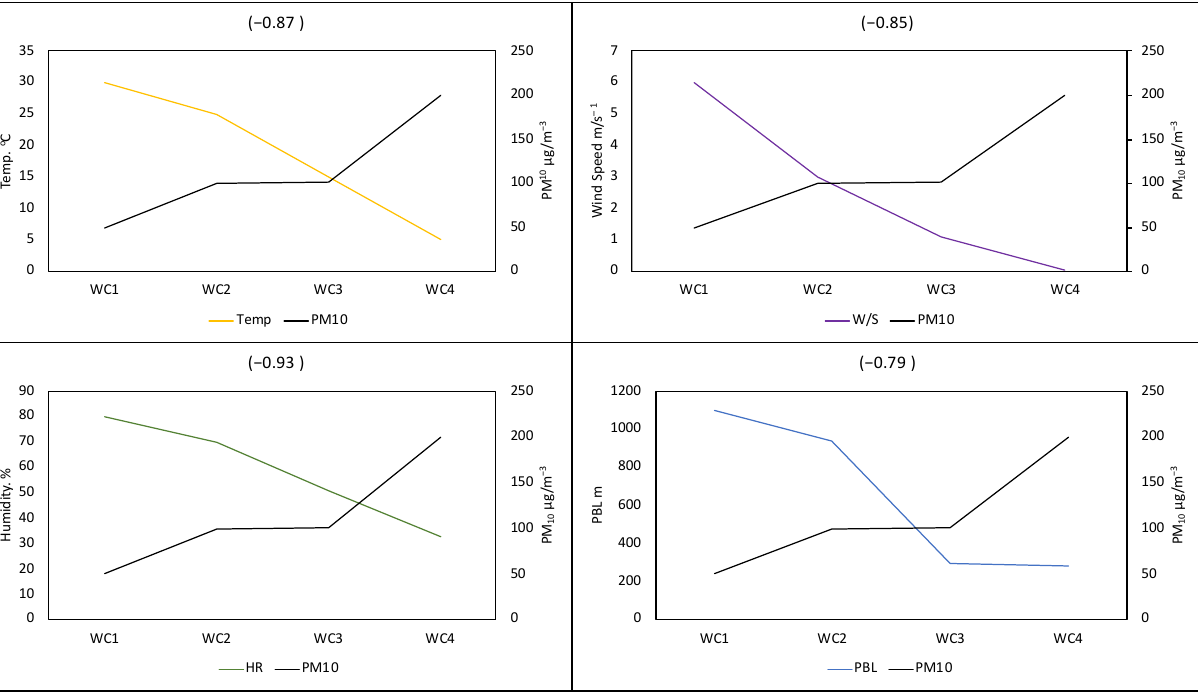
Figure 9. The correlation coefficient between PM 10 and the classified weather condition patterns. Table 5. The traced air mass transportation origin within a period of 24 h during the extreme PM 10 concentration